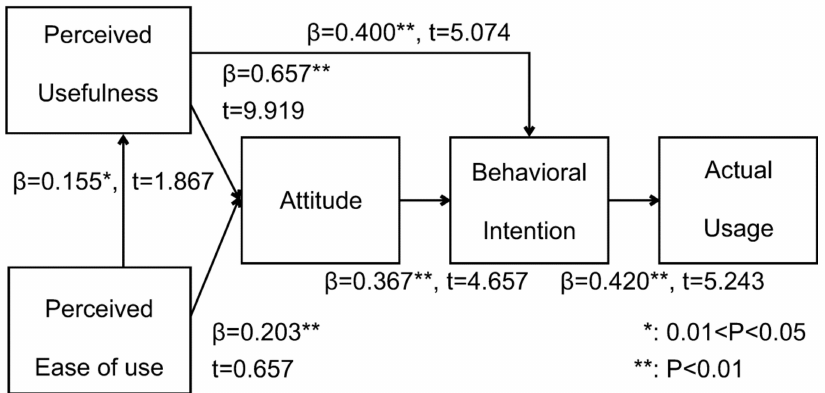
Figure 6. Analysis result model of the hypothesis test regarding the TAM of construction IT. β = Standardized Coe ffi cients; t = test statistics; p = significance probability ( p